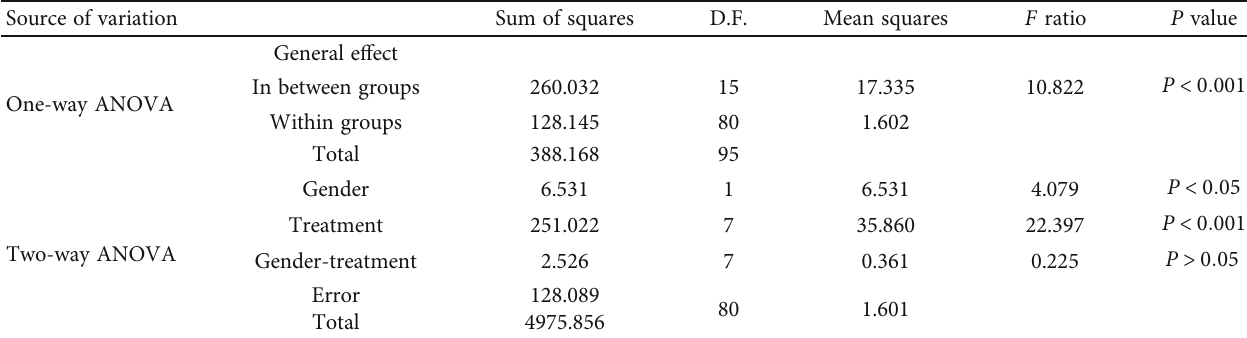
Table 8: One-way and two-way analysis to test the e ff ect of gender, treatment, and their interactions on GSH content in rats. Source of variation Sum of squares D.F. Mean squares F ratio P value One-way ANOVA